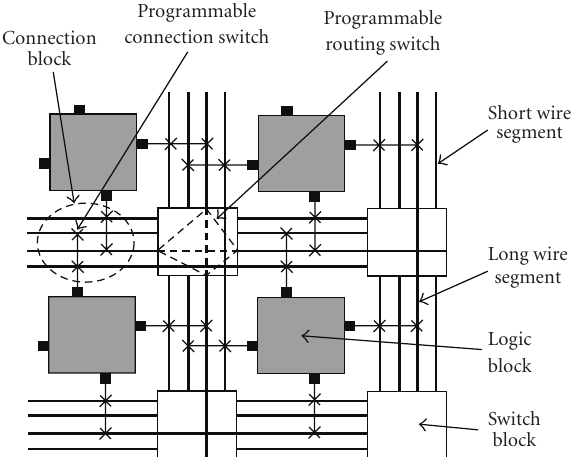
Figure 3: The architecture of island-style field programmable gate